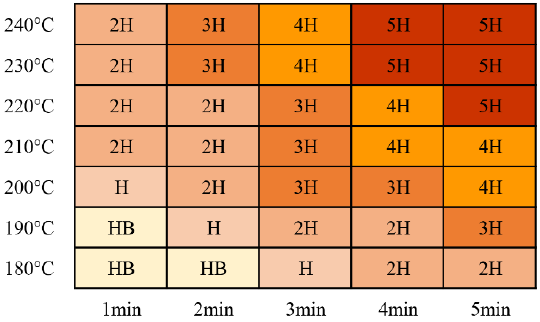
Figure 11. Changes in the coating gloss with curing time with different curing temperatures.